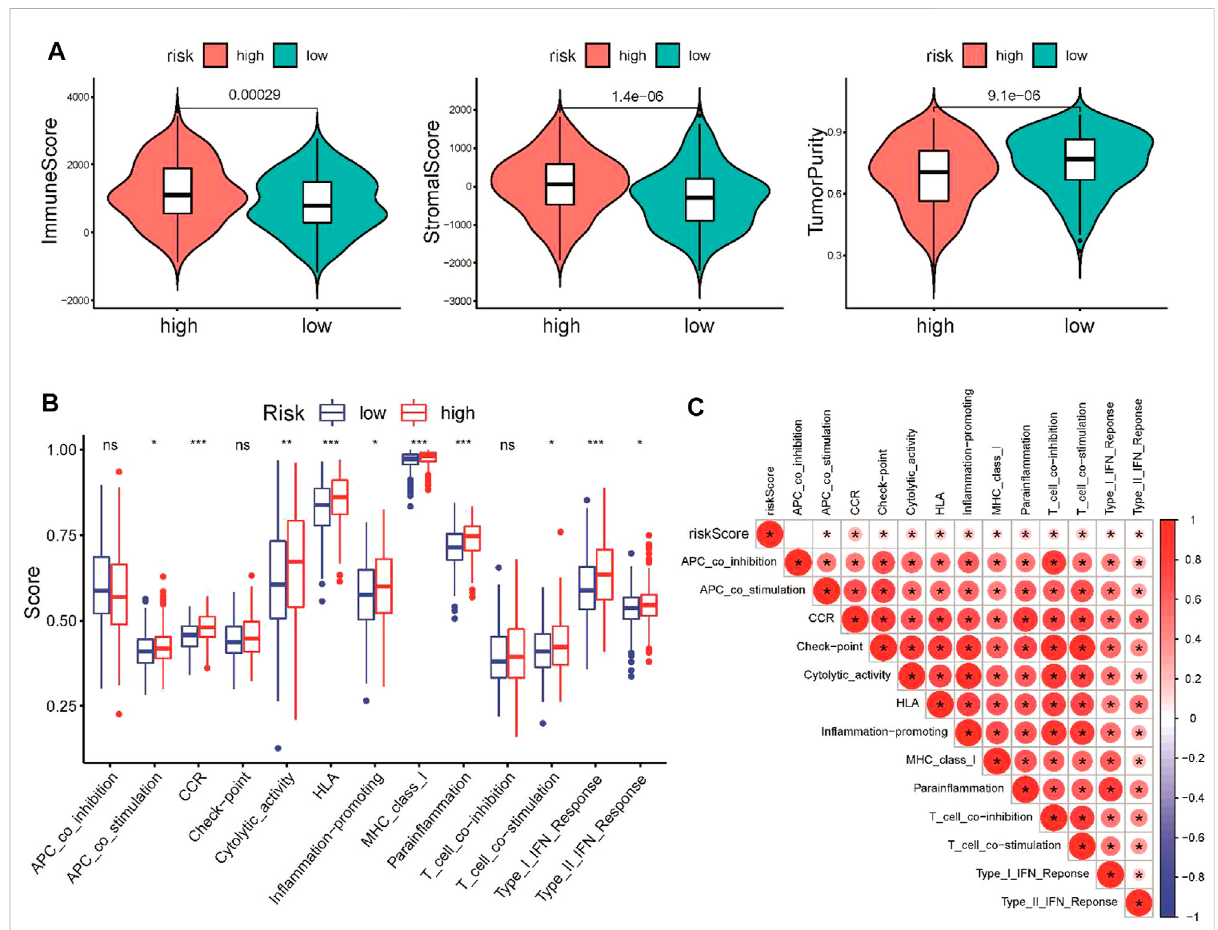
FIGURE 6 Comparison of immune activity between the high-risk and low-risk groups. (A) Comparison of immune score, stromal score, and tumor purity between the low- and high-risk groups. (B) Comparison of the enrichment scores of 13 immune-related pathways between the low- and high-risk groups. (C) Correlation of the risk score and immune-related pathways. * p < 0.05, ** p < 0.01, and *** p <